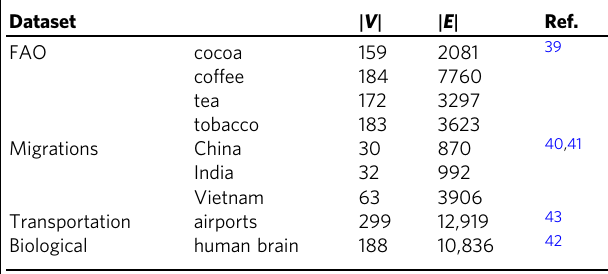
Table 1 Real-world fl ow networks and corresponding scales. Dataset